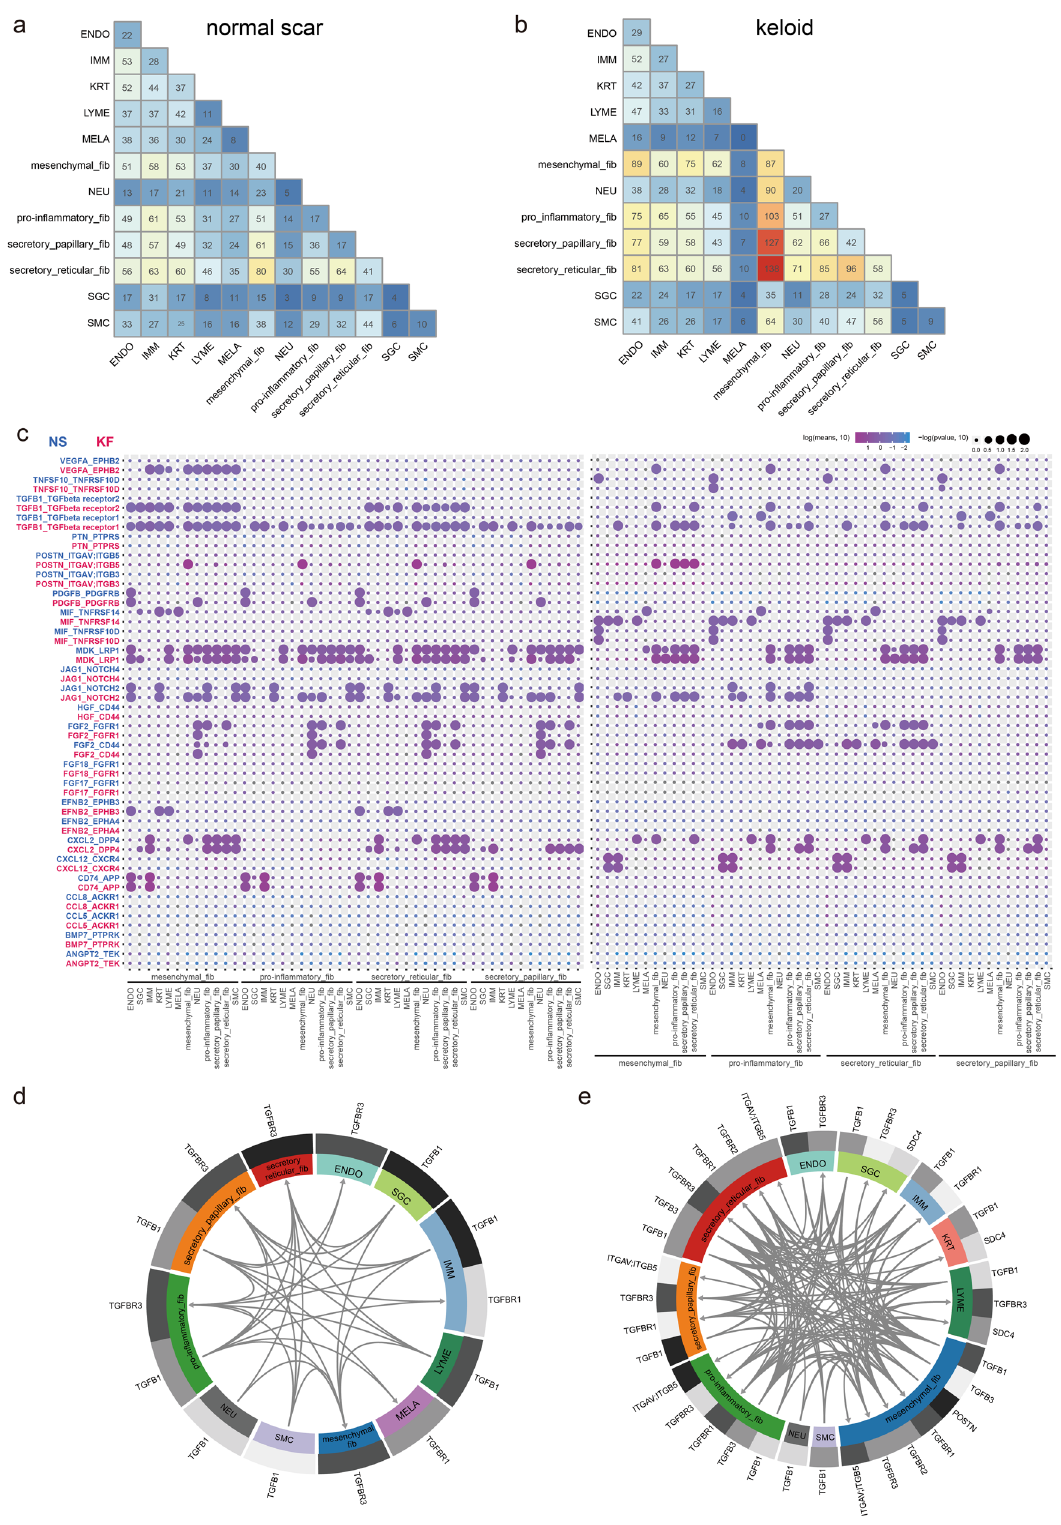
Fig. 4 Potential ligand – receptor interactions analyses in fi broblast subpopulations. a , b Heatmap showing the numbers of inter-populations communications with each other in normal scars ( a ) and in keloid tissues ( b ). c The ligand – receptor pairs exhibit signi fi cant changes in speci fi city between any one of the population and any one type of fi broblast in normal scars versus keloid. The left panel shows that one type of fi broblast expresses receptors and receives ligand signals from other populations. The right panel shows that one other population expresses receptors and receives ligand signals from one type of fi broblast. d , e Putative TGF β and POSTN relative signaling within fi broblasts and other cell populations in normal scars ( d ) and in keloid tissues ( e ). All arrows are pointing to the receptors. Average expression levels for each ligand/receptor are presented as a heatmap plot. Black indicates maximum relative expression and white indicates low or no expression of a particular